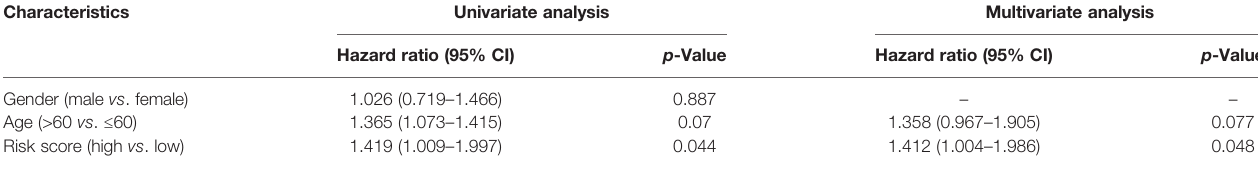
TABLE 4 | Univariate Cox and multivariate Cox regression analyses in validation cohort.